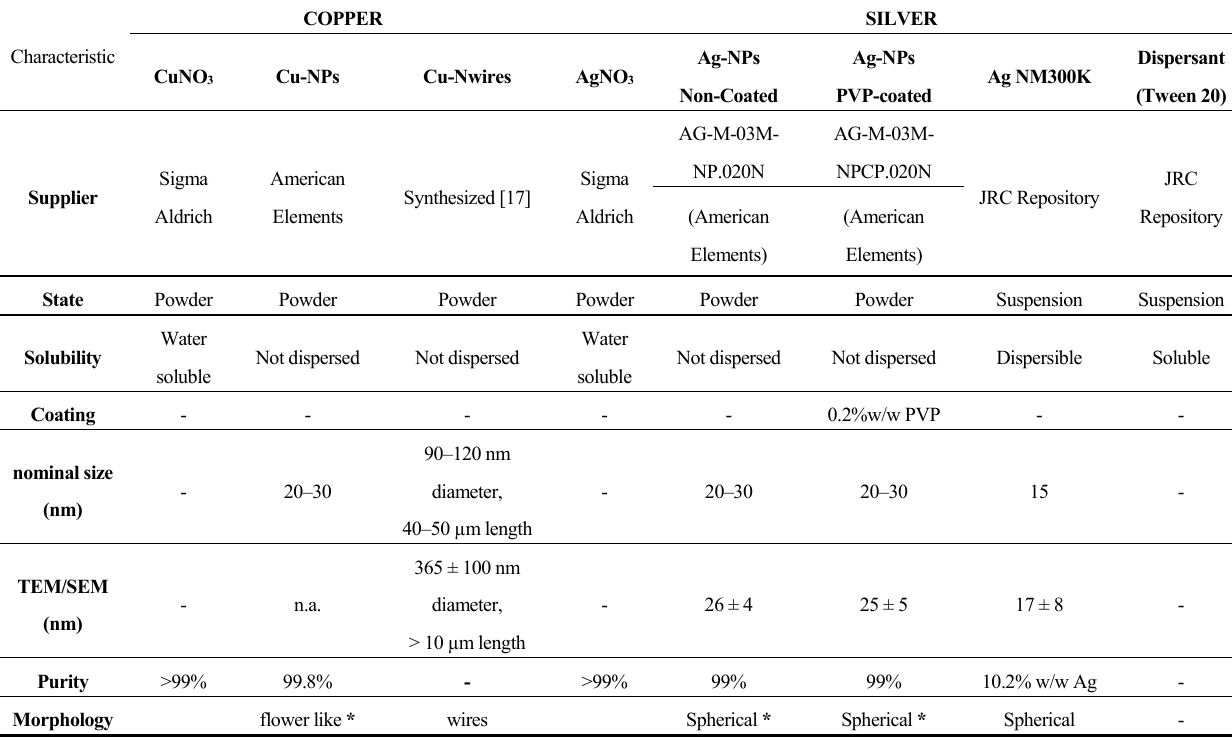
Table 1. Summary information of the characteristics of the tested materials in terms of supplier, state, solubility, coating, nominal size (according to the supplier), size according to Transmission or Scanning Electron Microscopy (TEM or SEM) measurements, purity and morphology. PVP: polyvinylpyrrolidone, w/w: wet weight.